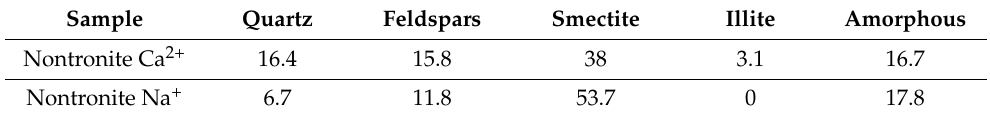
Table 2. Details of the cation exchange capacity of the clays. Table 3. Content of calcium and sodium nontronite obtained by XRD